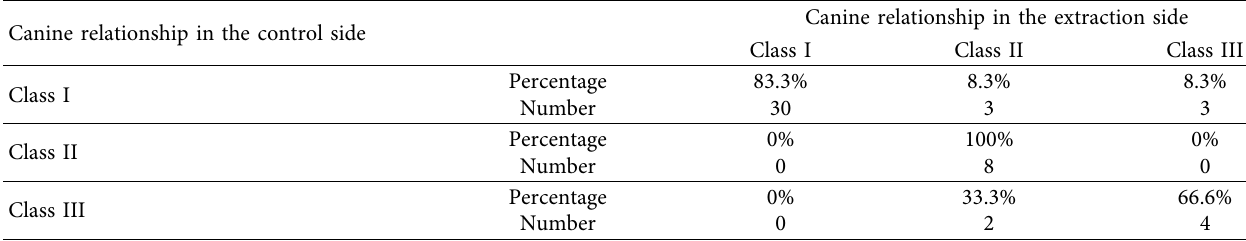
Table 6: Comparison of the canine relationship between the extraction and control